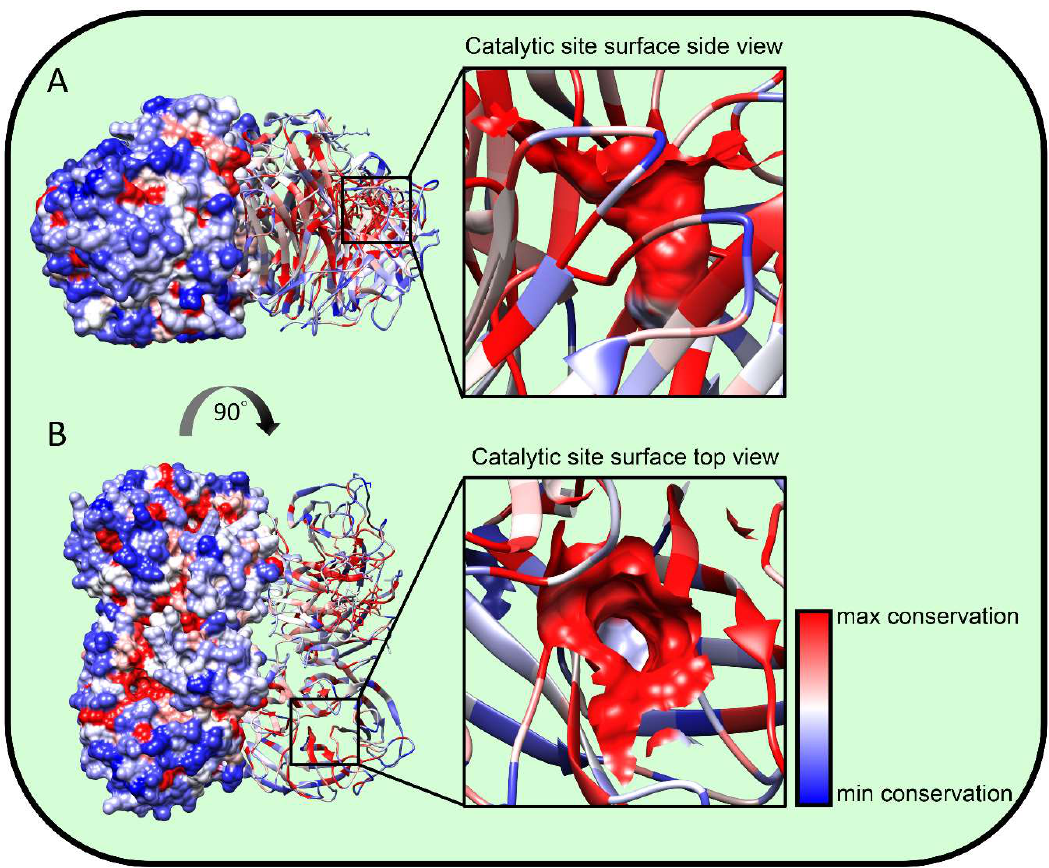
Figure 2. NA structural conservation. We aligned roughly 400 NA amino acid sequences from IAV strains spanning the last 100 years (200 hundred H1N1, 50 H5N1, and 150 H3N2) using MUSCLE software at the fludb website (www.fludb.org). We projected residue conservation onto the N2 NA A / Perth / 16 / 2009 H3N2 (pdb entry 6br5) structure using UCSF Chimera 1.13 software. Blue represents residues with maximal variability while red represents minimal variability. ( A ) Side view showing surface rendering of half the structure with the other half showing ribbon rendering, demonstrating the variability of NA surface residues vs. the conservation of internal residues. ( B ) Top view. The black squares show the catalytic site, which is magnified on the right. The residues forming the catalytic site are surface-rendered; note the high conservation except at the base, which is variable and consistent with its lack of substrate interaction.